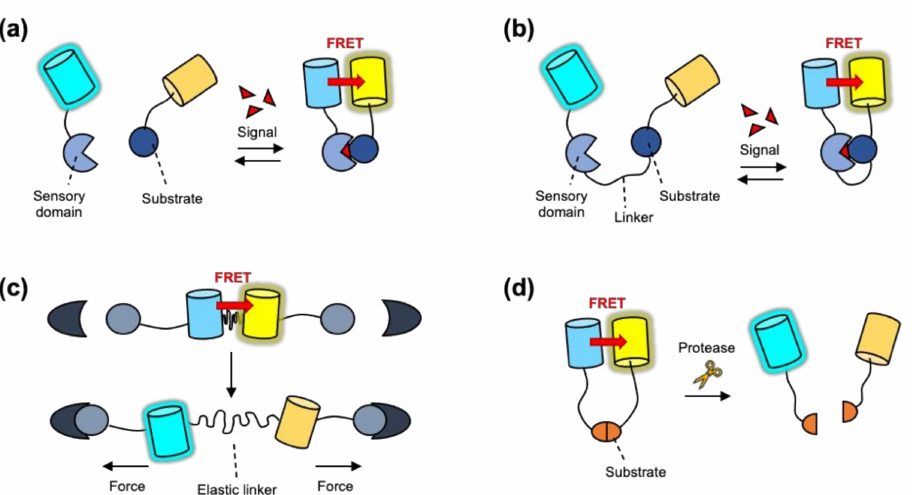
Figure 2. Designs of FRET biosensors ( a ) Representative design of an intermolecular FRET biosensor. The signal-induced interaction of the modified substrate and the sensory domain results in the increase of FRET between donor and acceptor FP. ( b ) Representative design of an intramolecular FRET biosensor. The signal-induced conformational change of the biosensor increases the FRET level. ( c ) Design of a FRET-based tension sensor. Its FRET level is designed to decrease by the applied tensional force. ( d ) Design of a FRET-based protease sensor. The activated protease cleaves its substrate, resulting in the decreased FRET of the